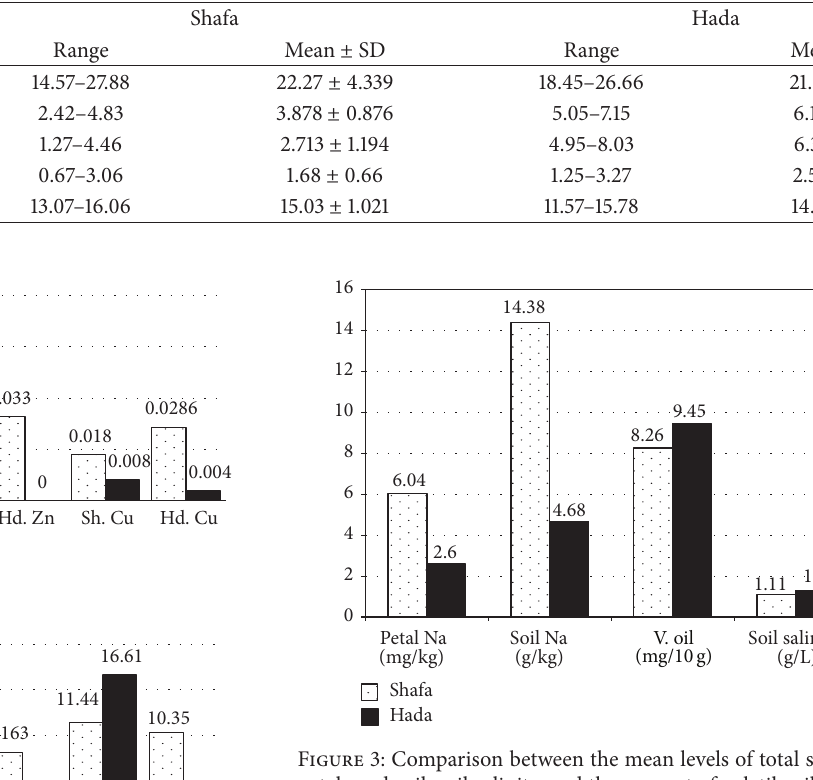
Table 5: Levels of some constituents of essential oil in concrete extracted from petals of flowers collected from Shafa and Hada farms.